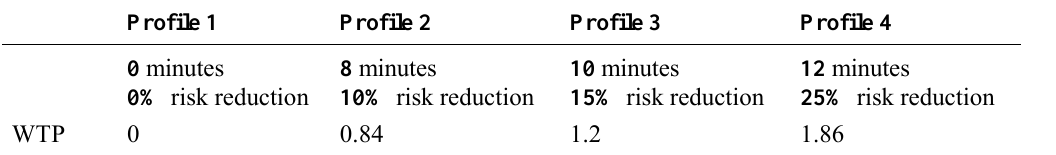
Table 4. Appraisal of a subset of four profiles